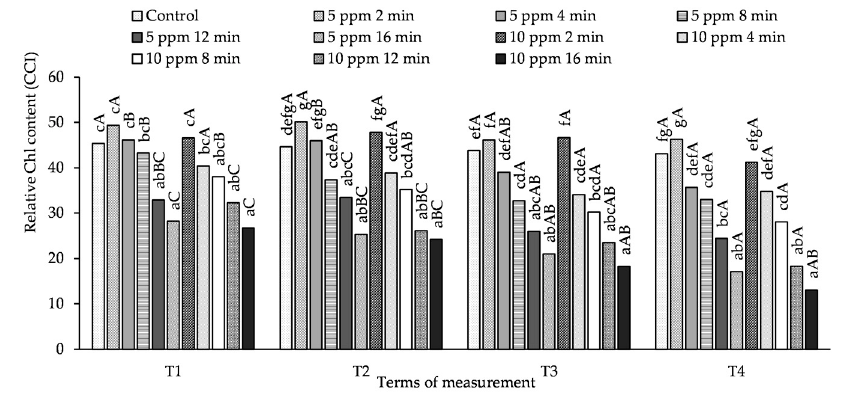
Figure 2. Changes in relative Chl content in potato leaves depending on O 3 concentration, exposure time and measurement terms (T1—1st day after the 1st fumigation, T2—7th day after the 1st fumigation, T3—1st day after the 2nd fumigation, T4—7th day after the 2nd fumigation). Lowercase letters indicate significant di ff erences between the means at respective measurement terms, capital letters indicate significant di ff erences between means at the measurement terms for the respective variants of O 3 concentration and exposure time ( p < 0.05).